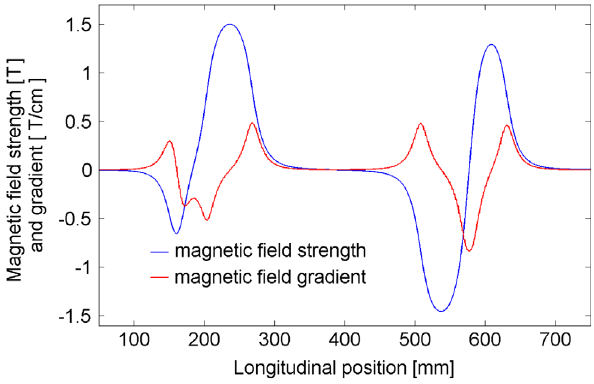
FIG. 15. Plot of the magnetic field strength and gradient distribution along the beam path.